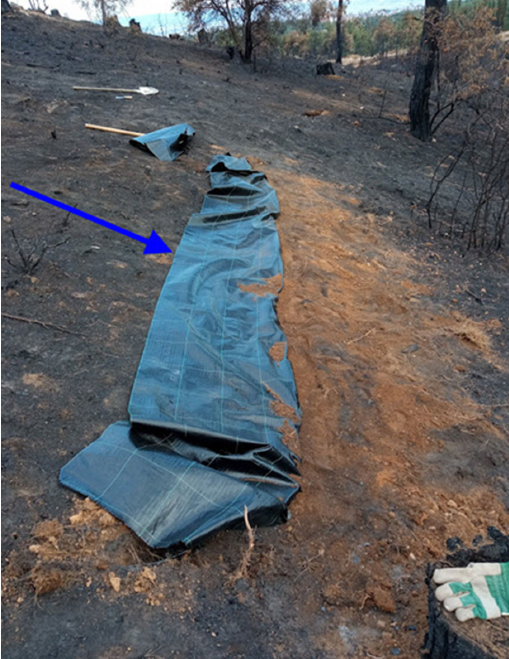
Figure 3. Silt fence installation process: the geotextile compacted with earth material in the trench. The blue arrow indicates the runoff direction. Subsequently, for each plot, five (5) metal rebars of 1.20 m long (10 mm diameter) were inserted in the ground to at least 30 cm depth, in order to uphold the silt fence (Figure 4). The number of the rebars was initially defined taking into account the cost and the transporting difficulties of such heavy equipment. Before the installation, the rebars should be thoroughly sharpened in one edge, to make easier the penetration in the ground. Small cable ties were used to fasten the silt fences on the rebars. Four or five cable ties were used for each rebar, while the lowest cable tie should be 25–30 cm above the ground to avoid tearing in the gathering area of the fence.